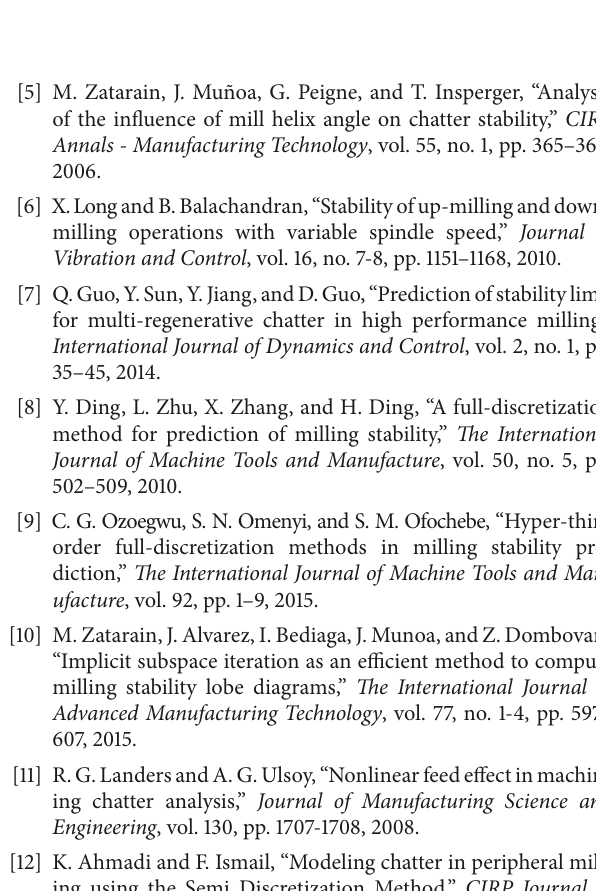
Figure 11: Frequency spectrum of 𝑦 -direction milling